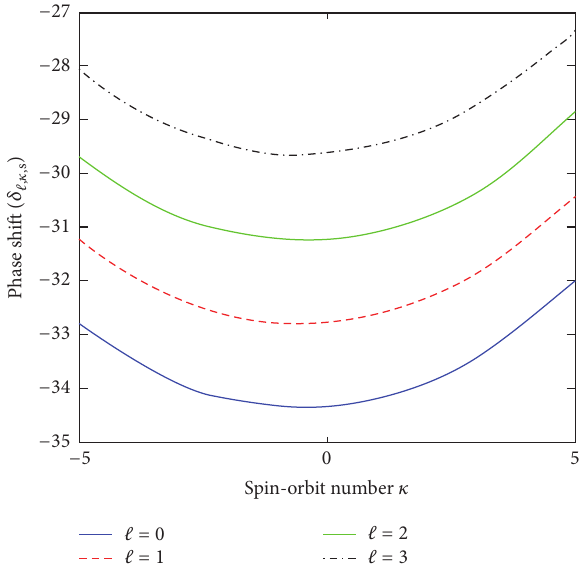
Figure 4: A plot of spin scattering phase shifts for the hyperbolical potential as a function of spin-orbit number 𝜅 for 𝑙 = 0, 1,2, 3 with positive potential parameter 𝜎 0 = 0.50 , 𝛼 = 0.50 , 𝑐 𝑜 = 1/12 , 𝐶 s = 10 , 𝐷 = 10 , and 𝐸 = 𝑀 = 1 . The relativistic mass and energy are equal in all the